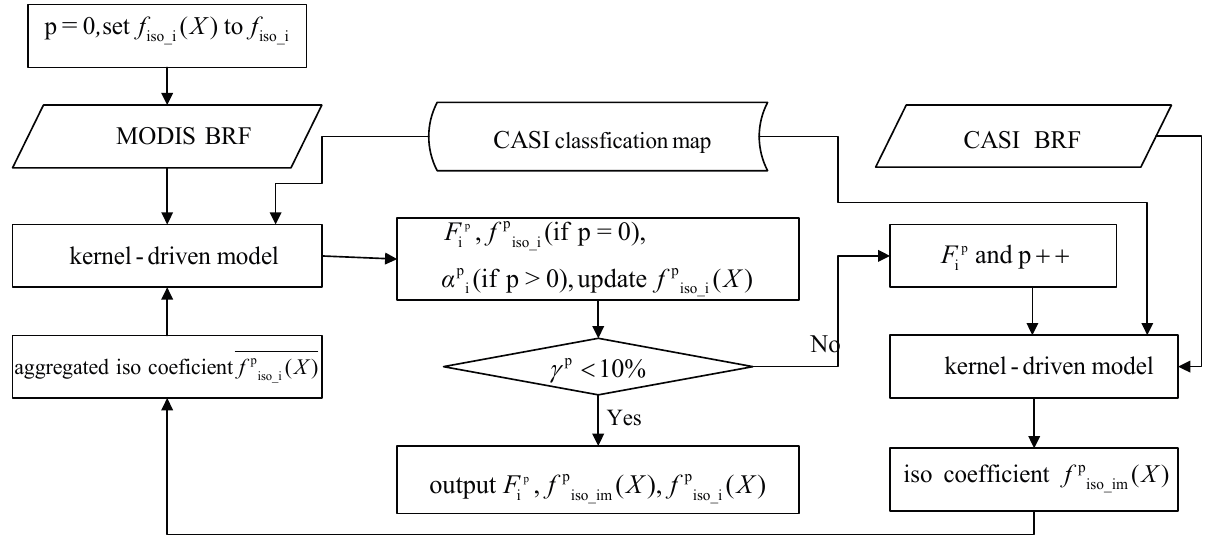
Figure 2. The flowchart for the LLBU inversion